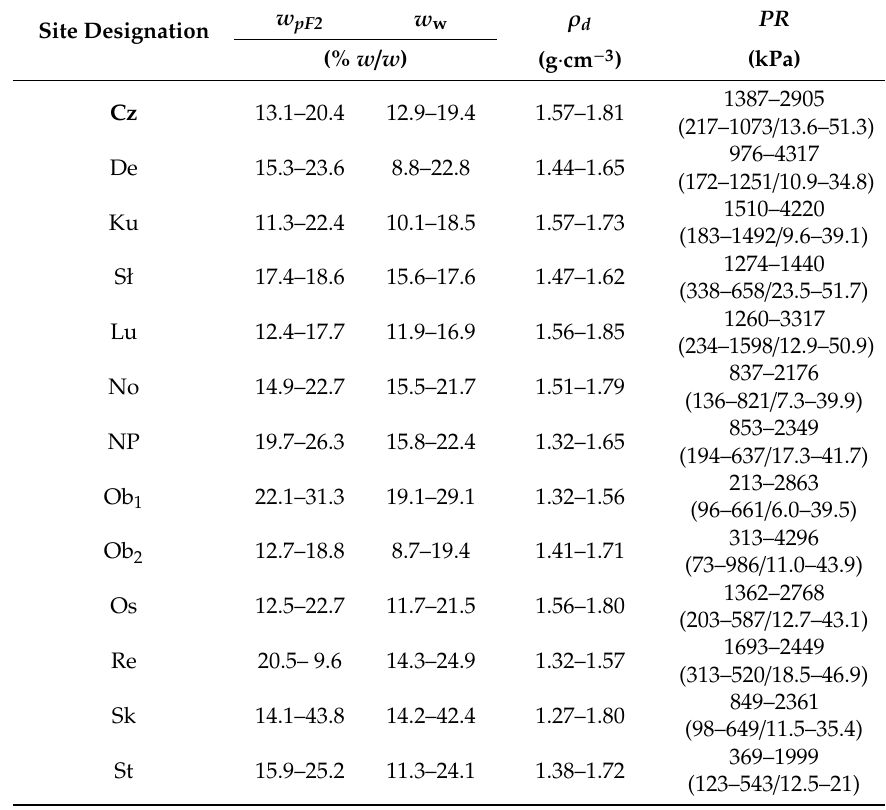
Table 2. Ranges of average values of physical properties determined for all cases within individual